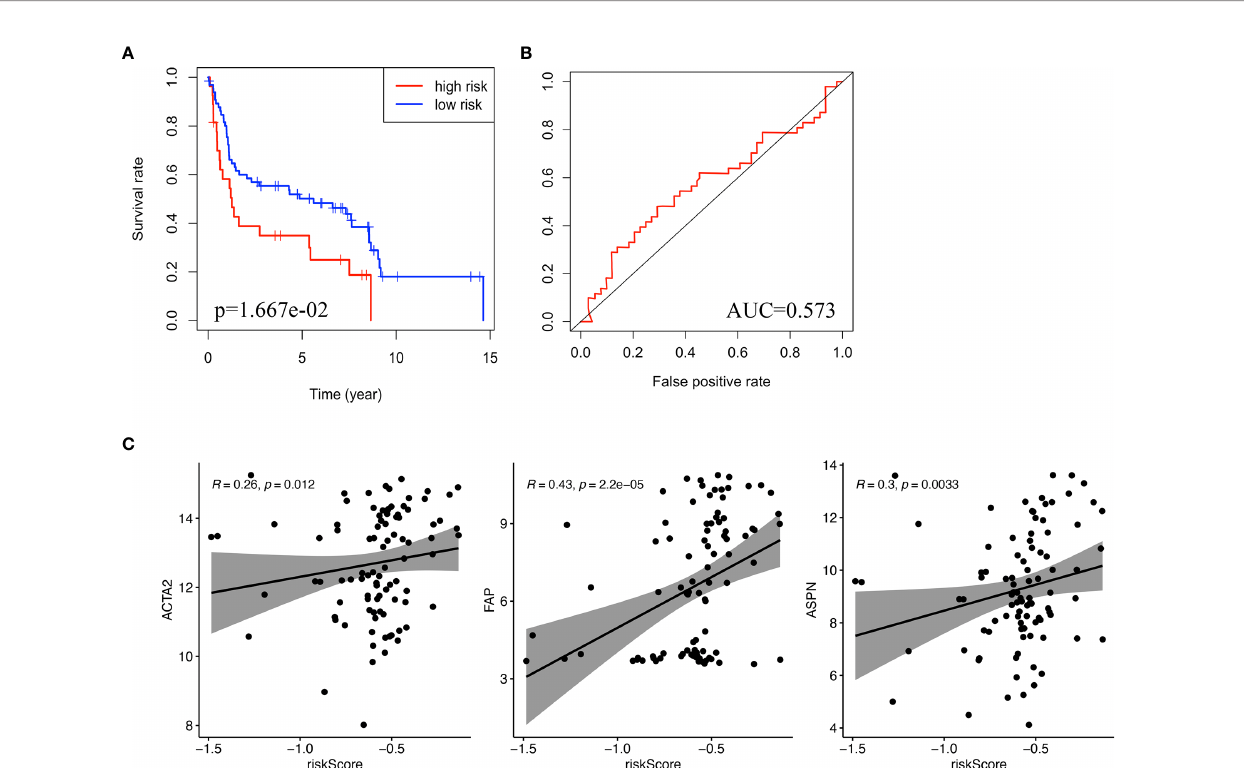
FIGURE 7 | Validation of the lncRNA signature. (A) Kaplan-Meier curve for overall survival of bladder cancer patients in validation cohort (GSE31486). (B) ROC curve and AUC of the lncRNA signature in validation cohort. (C) The correlation between risk score and biomarkers of fi broblasts (ACTA2, FAP, ASPN) in validation cohort. ROC, receiver operating characteristic; AUC, area under the ROC